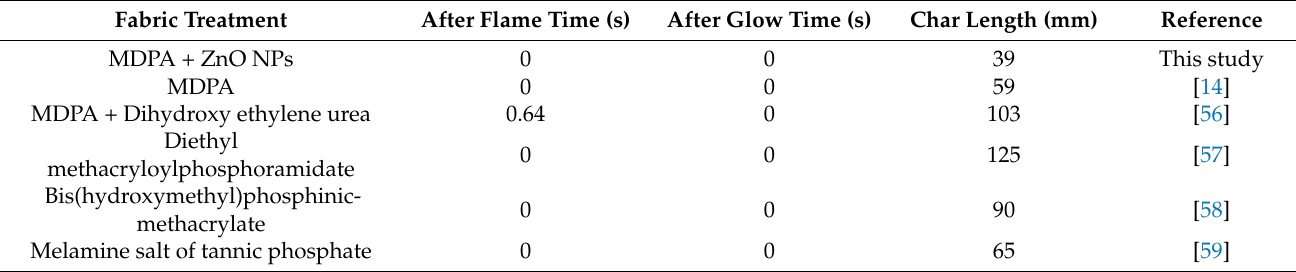
Table 4. Comparison of flame